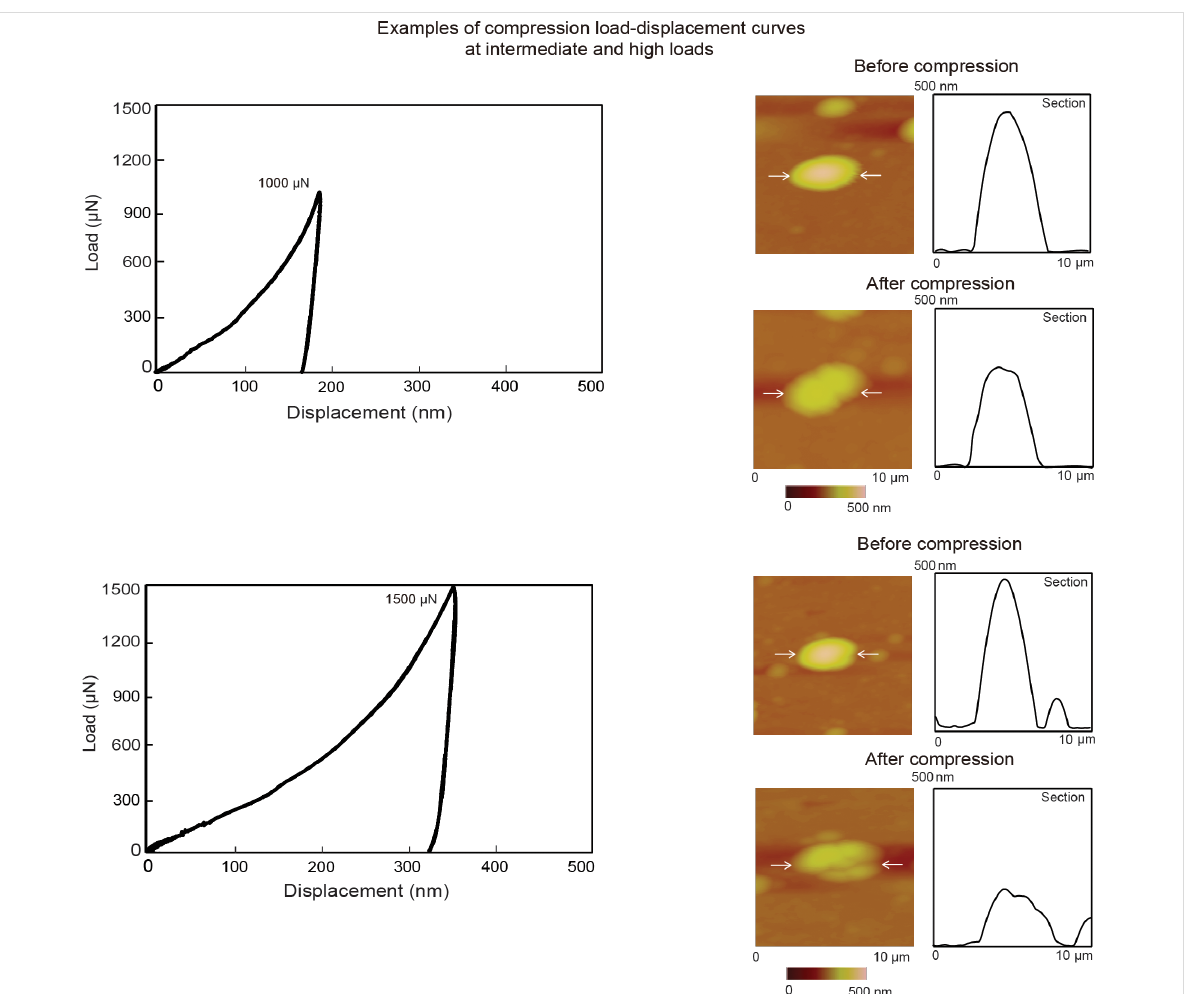
Figure 11: Load–displacement curves for intermediate loads 1000 µN and high loads 1500 µN with topography maps and 2-D profiles at sections shown by the arrows, before compression (first row) and after compression (second row).